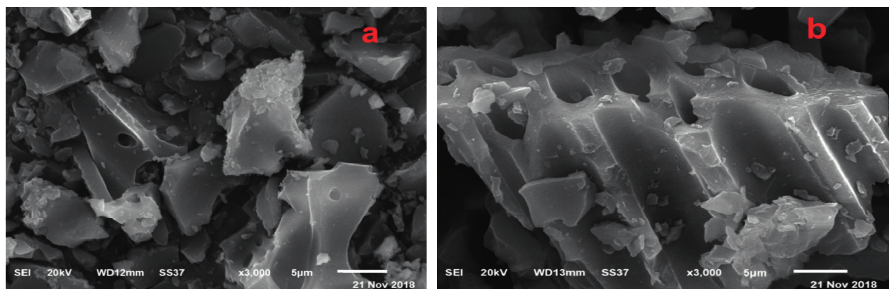
Figure 1: SEM images of the AC adsorbent. (a) AC only and (b) AC +BG dye.